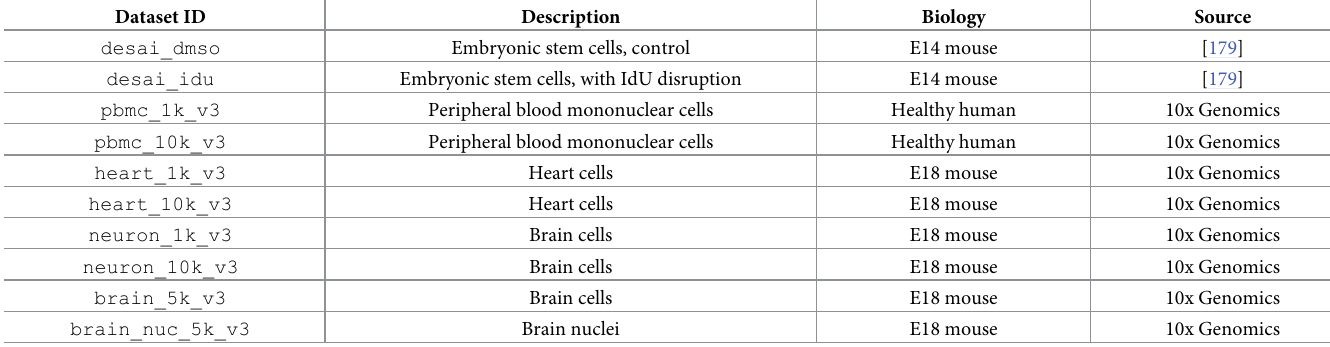
Table 1. The datasets used to compare performance of molecule quantification